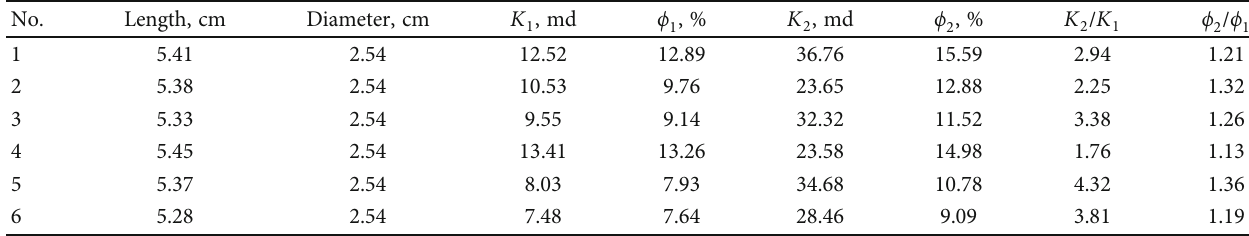
Table 1: The fl ooding results of group core